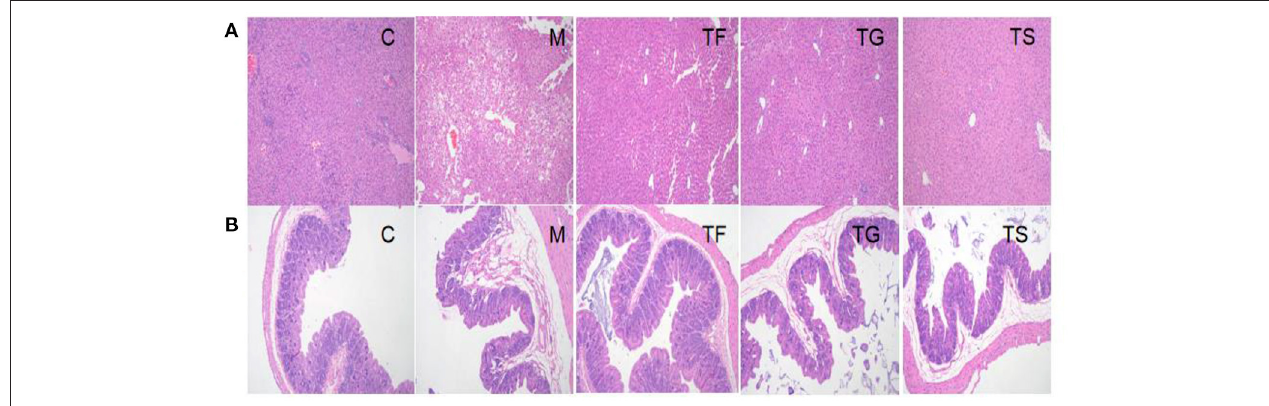
FIGURE 4 | Pathological analysis of (A) liver and (B) caecal tissues from mice in different groups by HE staining ( × 100). C: normal control group; M: HFD + STZ-induced diabetes (model) group; TF: HFD + high-dose GABA-rich sprouted adzuki beans (35 g/100g) group; TG: HFD + GABA intervention (0.1 g/kg) group; TS: HFD + metformin (0.1 g/kg)